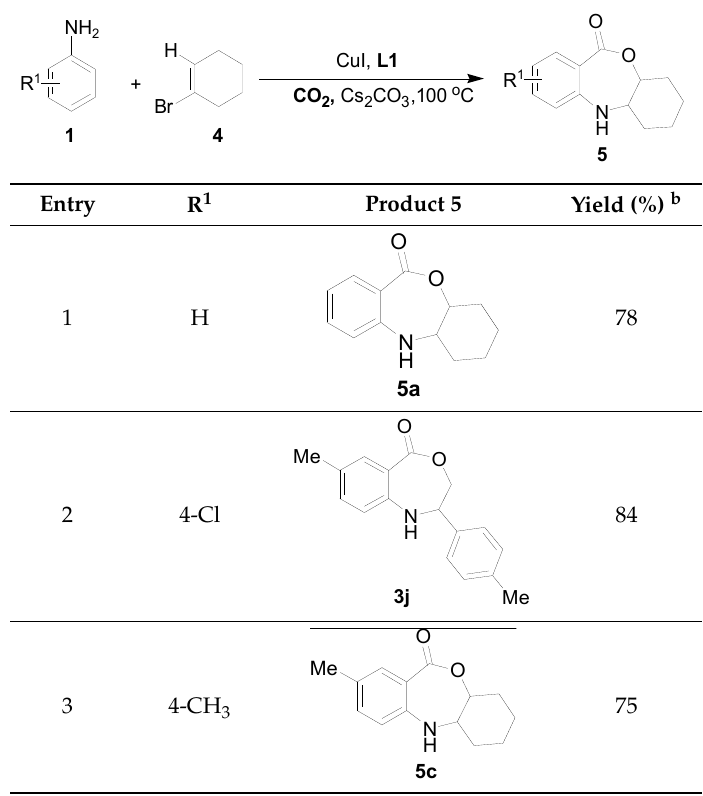
Table 3. Synthesis of benzo-1,4-oxazepin-5-one 5 a .